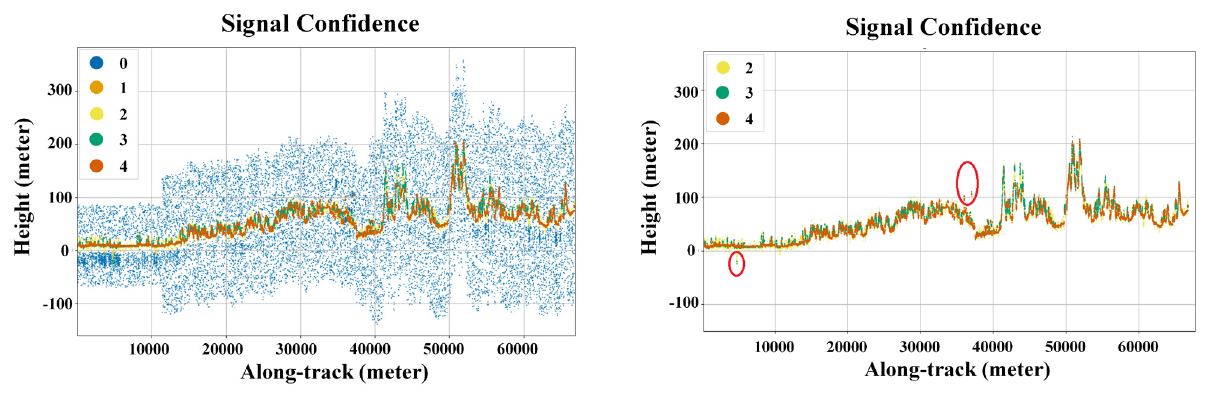
Figure 2. Photon outlier removal via confidence selection.